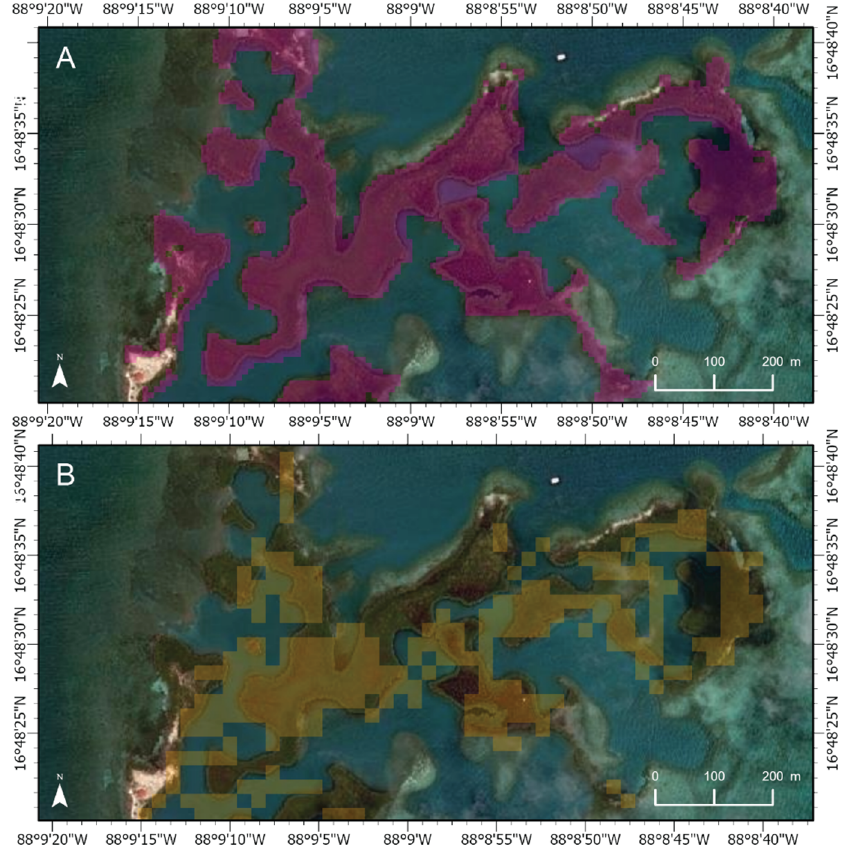
Figure 4. Comparison of mangrove cover in cayes identified by ( A ) this study and ( B ) Bunting et al. [22], demonstrating the advantage of higher-resolution data for mapping small mangrove cayes.